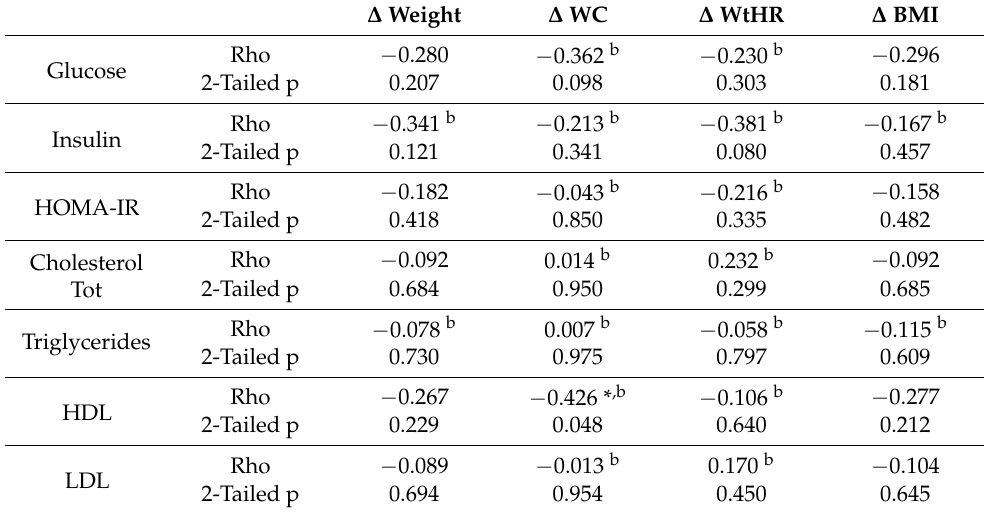
Table 4. Correlations between the differences in each anthropometric variable and the blood bio- chemical parameters between T1 and T0 for the risperidone group.